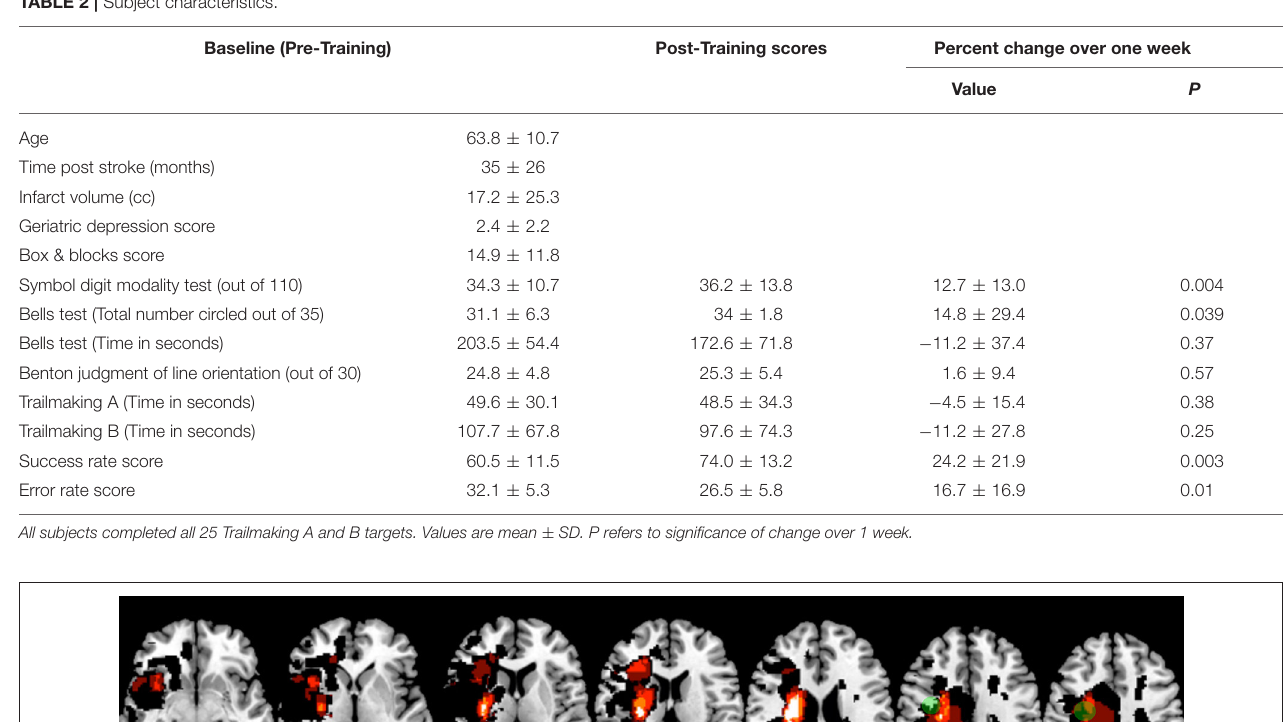
TABLE 2 | Subject